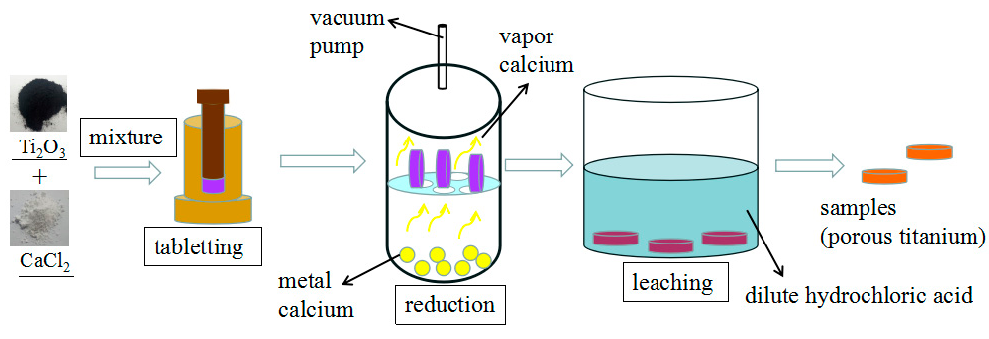
Figure 1. Schematic representation of the experiment.